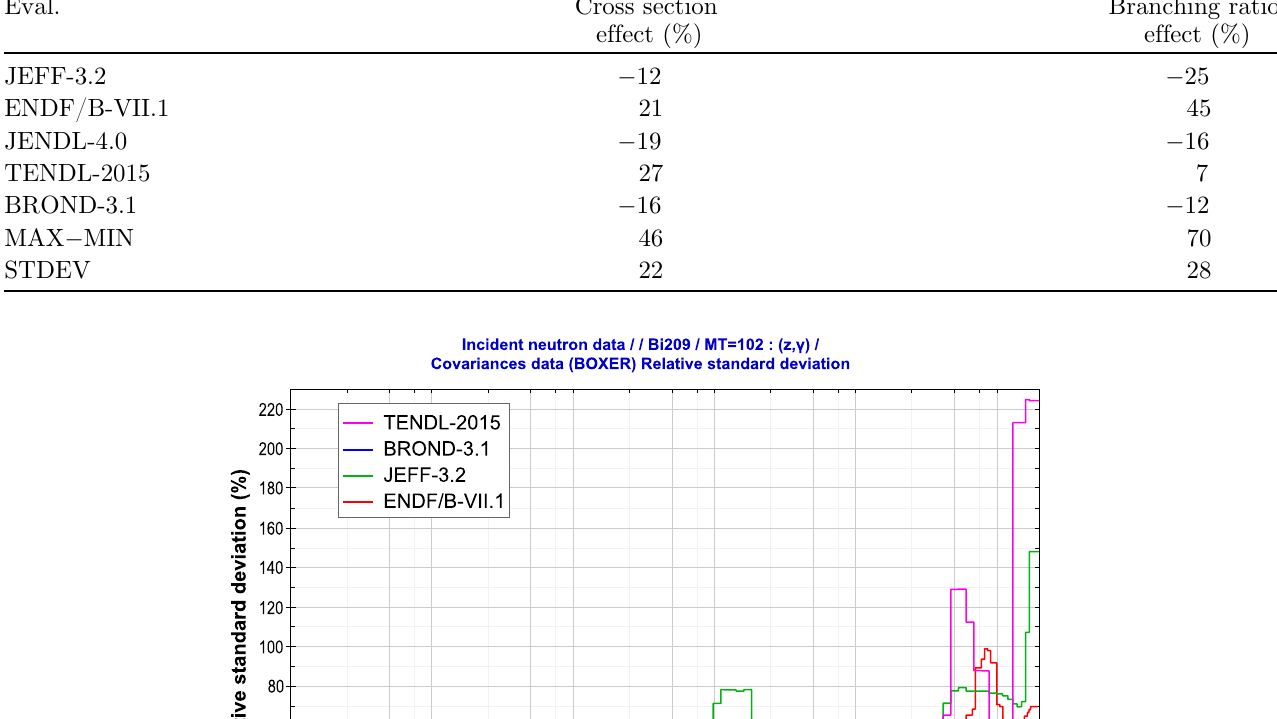
Table 2. Relative difference between the 210 Po concentrations. The value obtained with each library by replacing either ( h , g ) cross sections or branching ratios is compared to the 210 Po concentration obtained when averaging the results of all the libraries. MAX (cid:1) MIN is the largest difference in 210 Po obtained with two libraries. Eval.